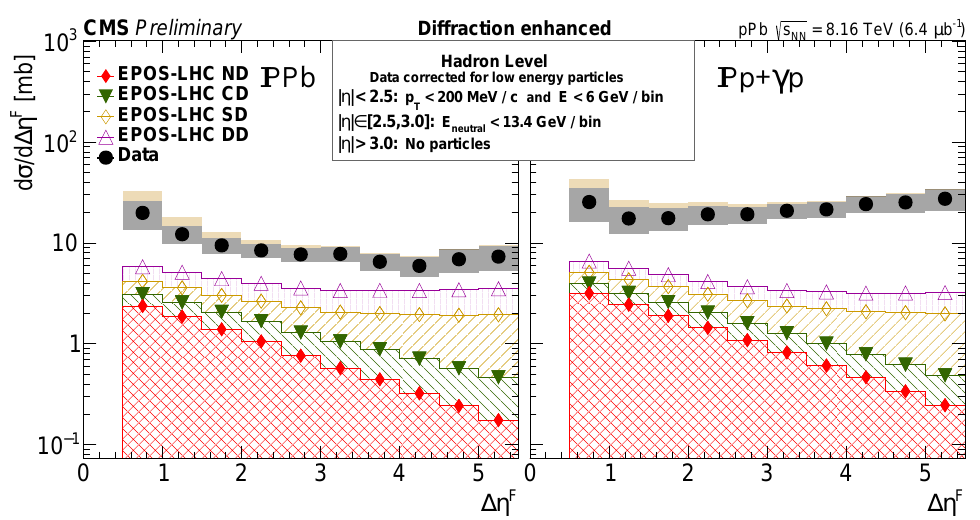
σ Figure 3: The hadron-level d distribution for the events with no energy deposition d ∆ η F in the 3.15 < | η | < 5.2 region adjacent to FRG for the EPOS-LHC [ 24 ] generator, broken down to non-diffractive (red), single (magenta), central (green) and double (yellow) diffractive events compared to CMS results [ 16 ]